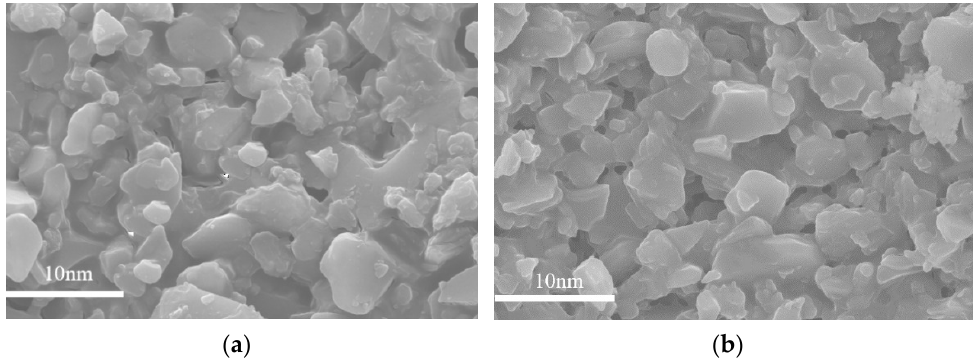
Figure 11. SEM images of surface topography for ( a ) MSiO 2 and ( b ) ZrO 2 -MSiO 2 (n Zr = 0.15) mem- branes with 0% DCCA addition calcined at 400 °C.